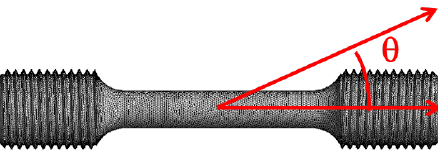
Figure 10. A generic model of the